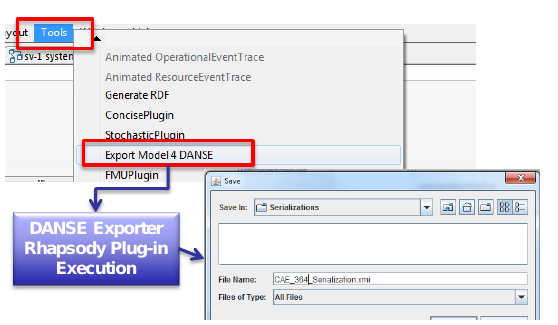
Figure 6. Export to DESYRE of IBM Rhapsody Model Representing the SoS